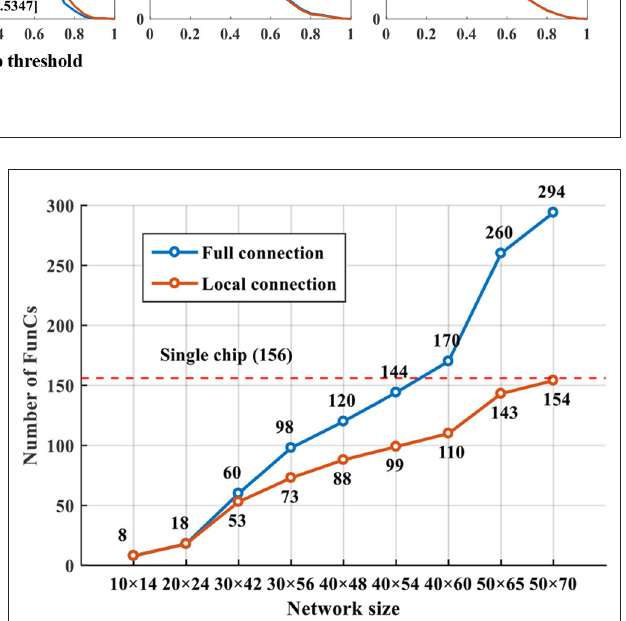
FIGURE 17 | Resource overhead before and after adding the local-connection restriction. TABLE 4 | Parameter configuration.